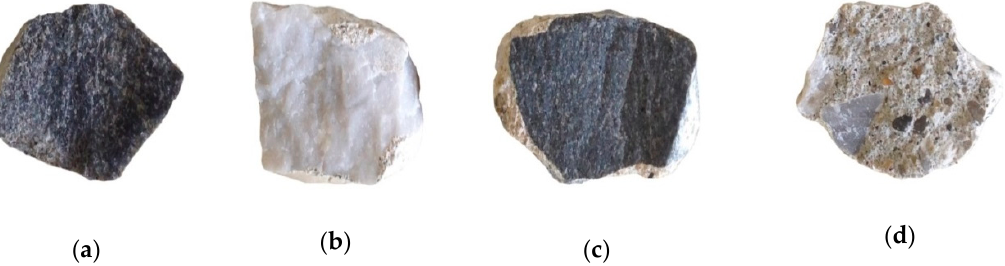
Figure 3. Size distributions of the coarse natural and recycled aggregates.